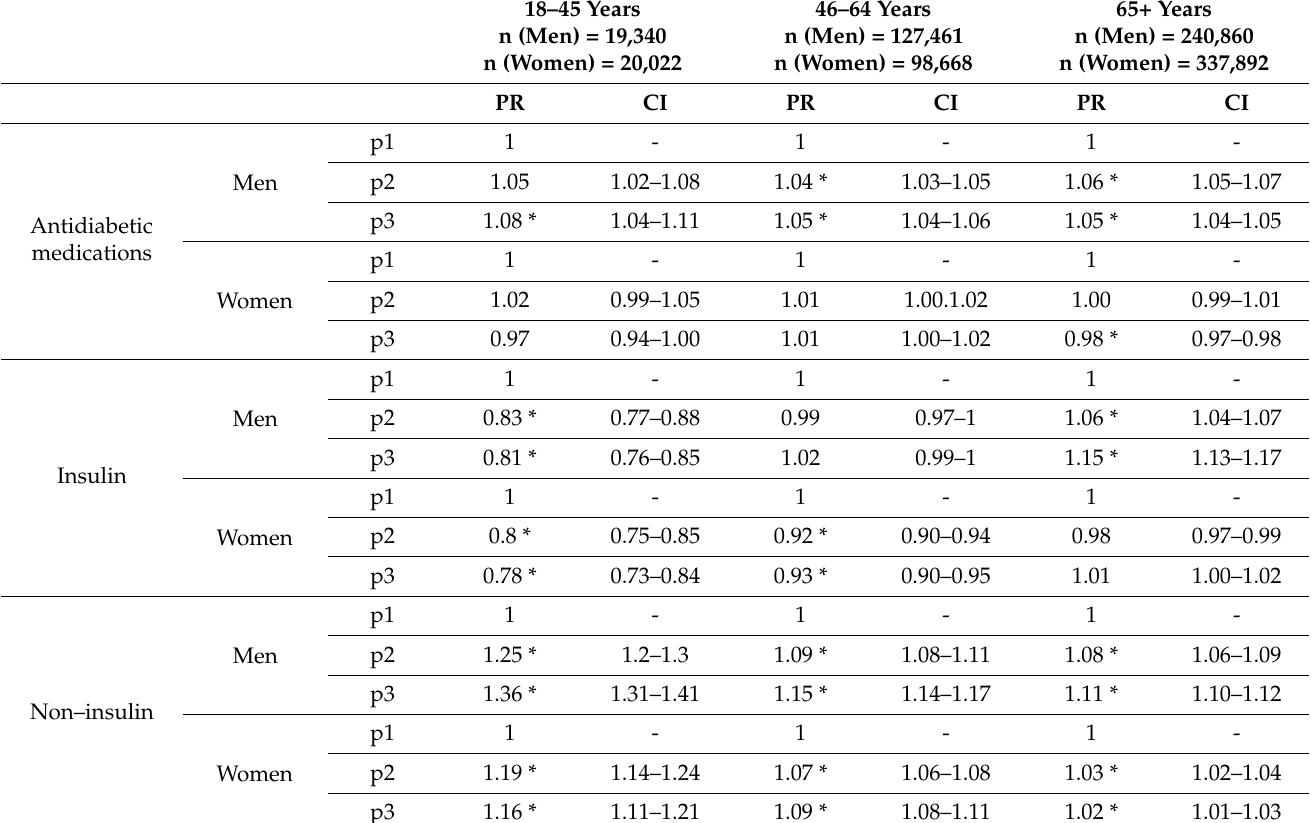
Table 3. Prevalence ratios and confidence intervals on the effect of time period on antidiabetic and CVD medications, stratified by age and gender as estimated by means of logistic regression. Adjusted for age (within each age group) and insurance